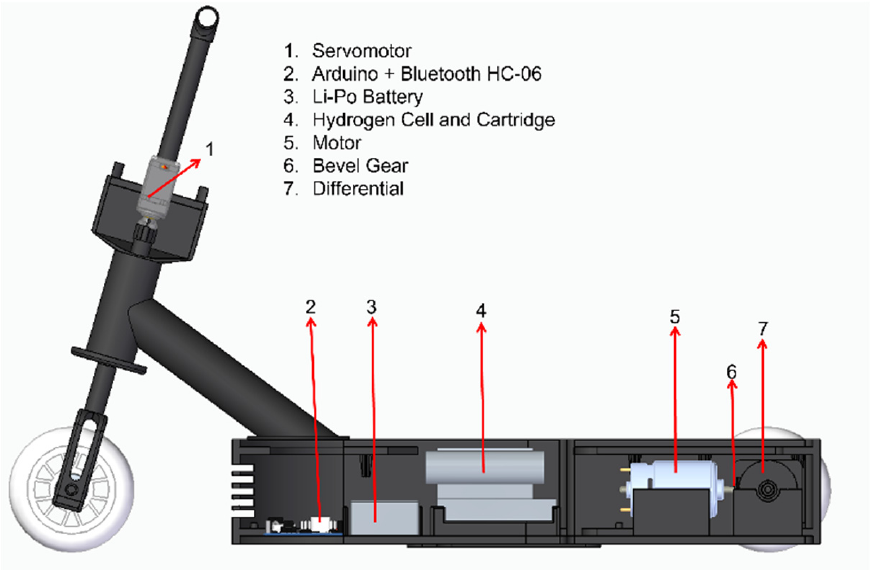
Figure 2. Sectional view of the vehicle and its internal components.